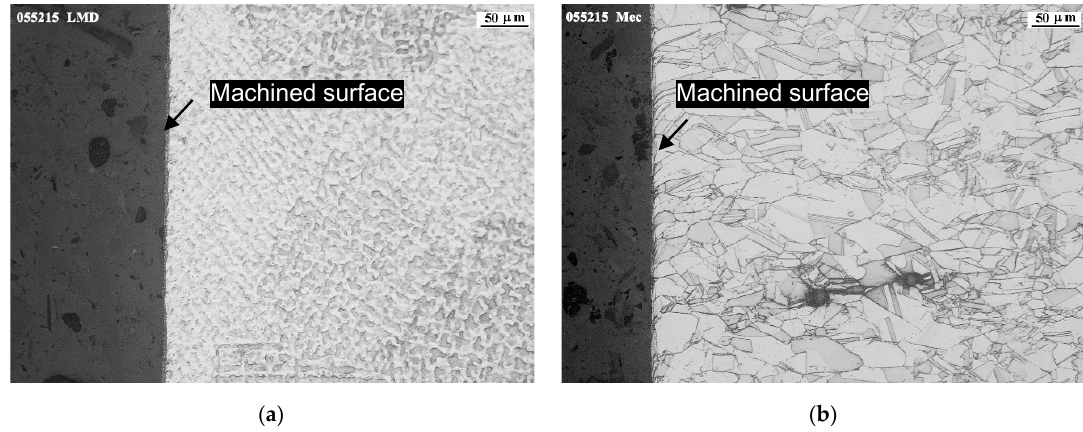
Figure 18. Cross-cut metallography images for: ( a ) milling LMD-AD, ( b ) milling forged-SA.